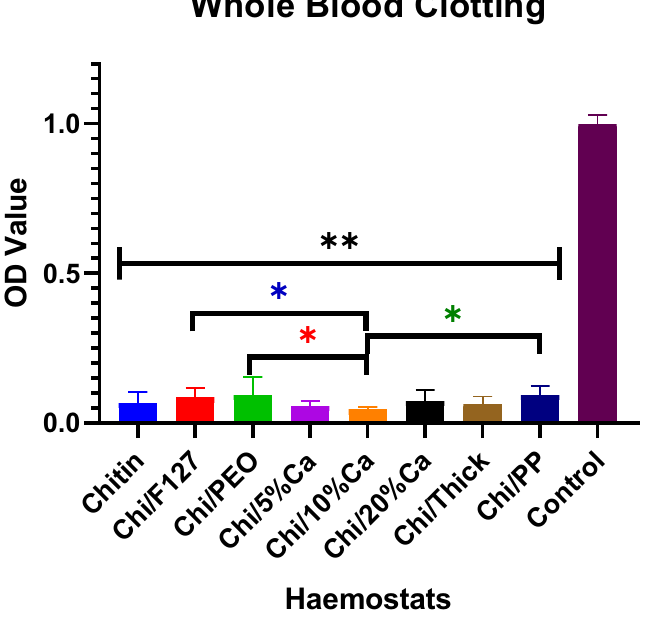
Figure 5. The effect of chemical and structural modification on whole blood clotting ability of the beta-chitin patch. The absorbance (OD value) of non-modified beta-chitin patch (Chitin), Chi/F127, Chi/PEO, Chi/5%Ca, Chi/10%Ca, Chi/20%Ca, Chi/Thick and Chi/PP are normalised to negative control. Lower absorbance indicates higher clotting. **p < 0.001 means significantly higher compared to the modified and non-modified beta-chitin patches, *p < 0.05 means significantly lower compared to Chi/PEO, *p < 0.05 means significantly lower compared to Chi/F127 and *p < 0.05 means significantly lower compared to Chi/PP; analysed by Kruskal–Wallis one-way ANOVA with Dunn’s test, n = 5.